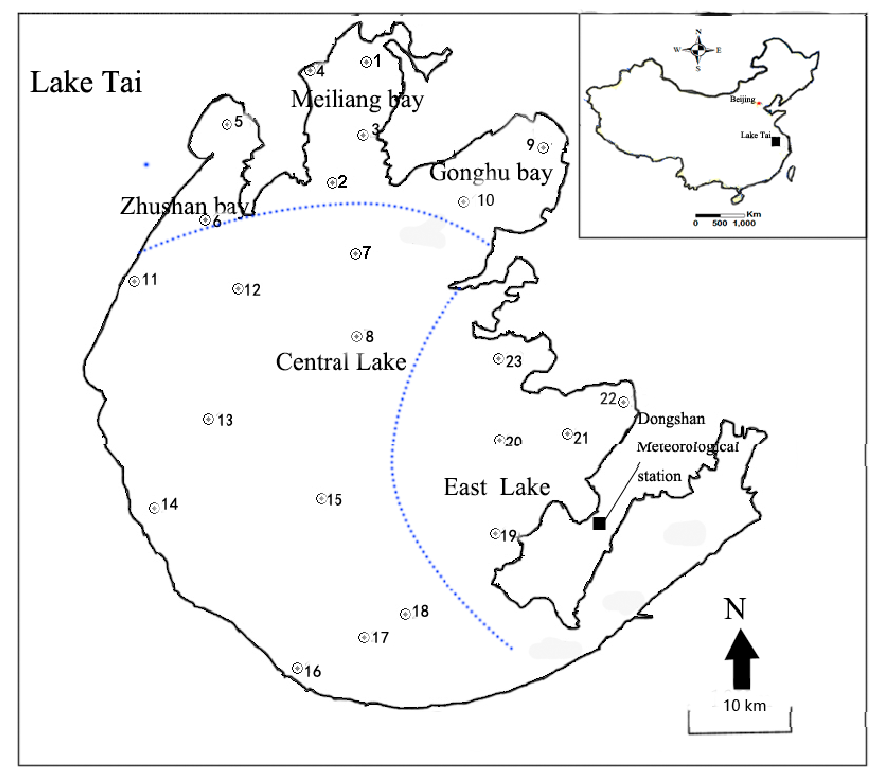
Figure 1. Map showing the location and five zones (i.e., Meiliang Bay, Zhushan Bay, Gonghu Bay, Central Lake and East Lake) of Lake Tai, superimposed by the 23 water quality sites and the meteorological station where data were available and used in this study.